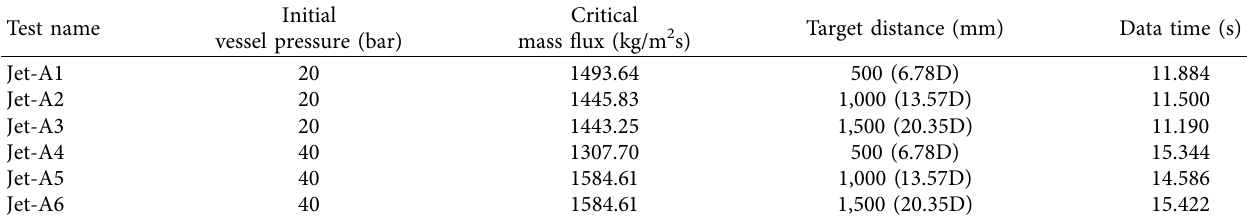
Table 1: Conditions of the validation analysis for the in-compartment jet-collision